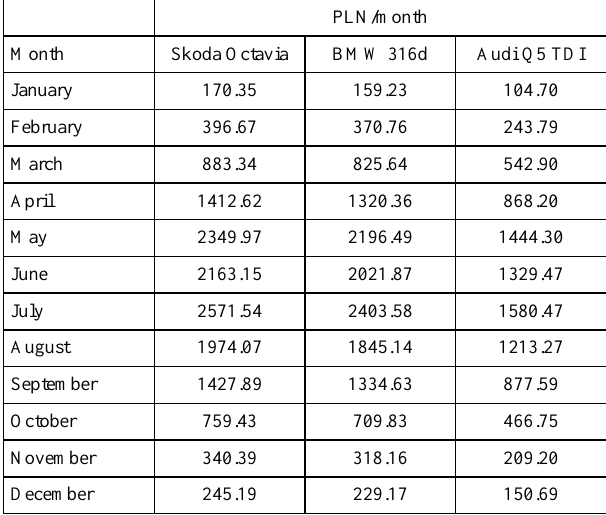
Table 22. Economical savings provided by PV system usage to power EV Diesel vehicles compared